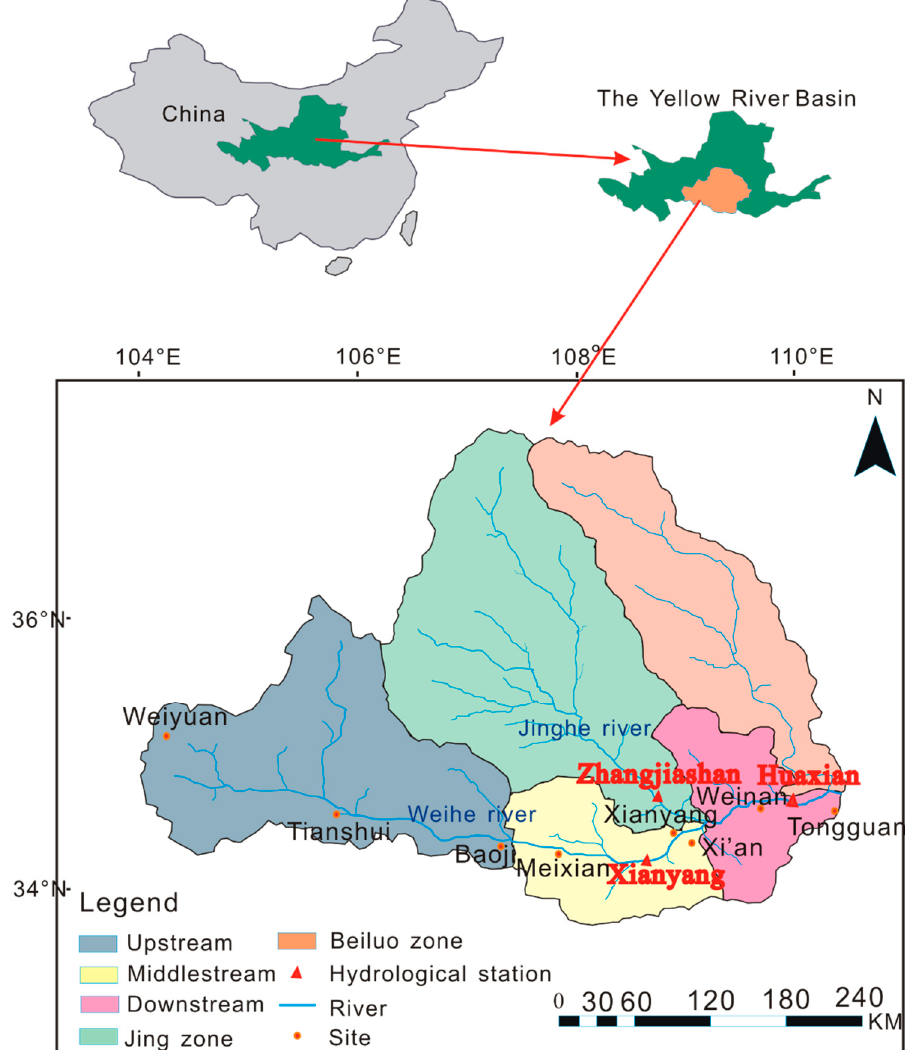
Figure 1. Locational map of the researching area.